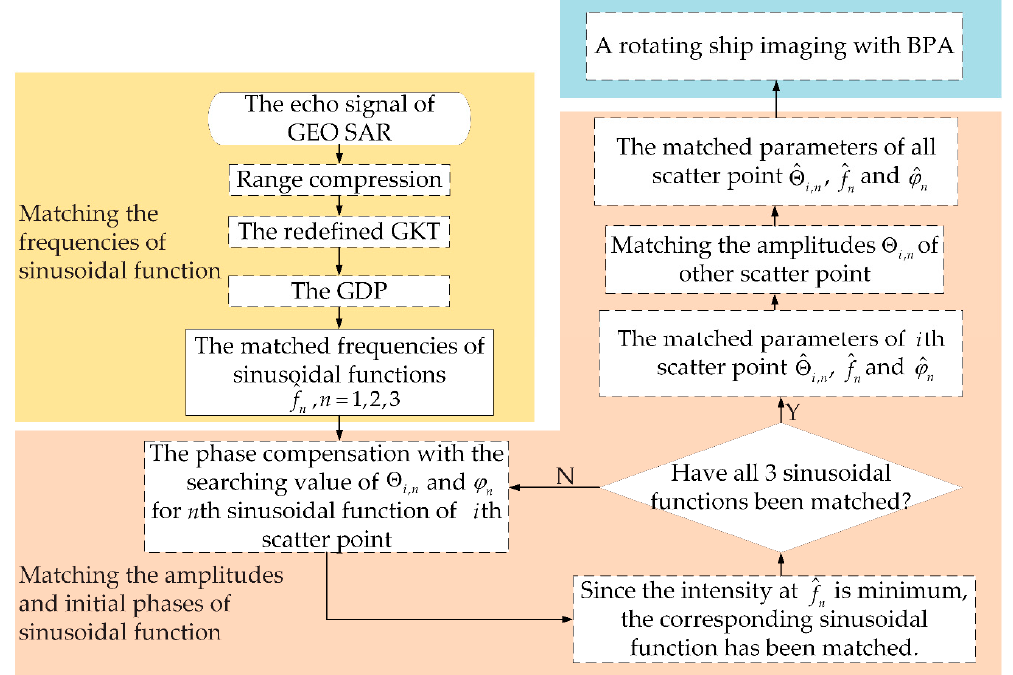
Figure 3. The multiple sinusoidal function matching-based ship imaging procedure.